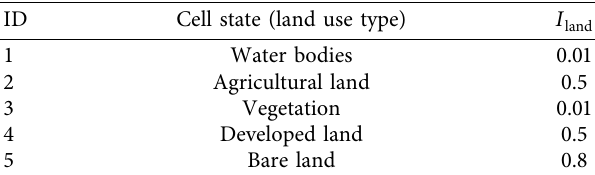
Figure 7: The number of the contributing neighborhoods ( N ) for lake cells. Table 2: The initial Activities of land use